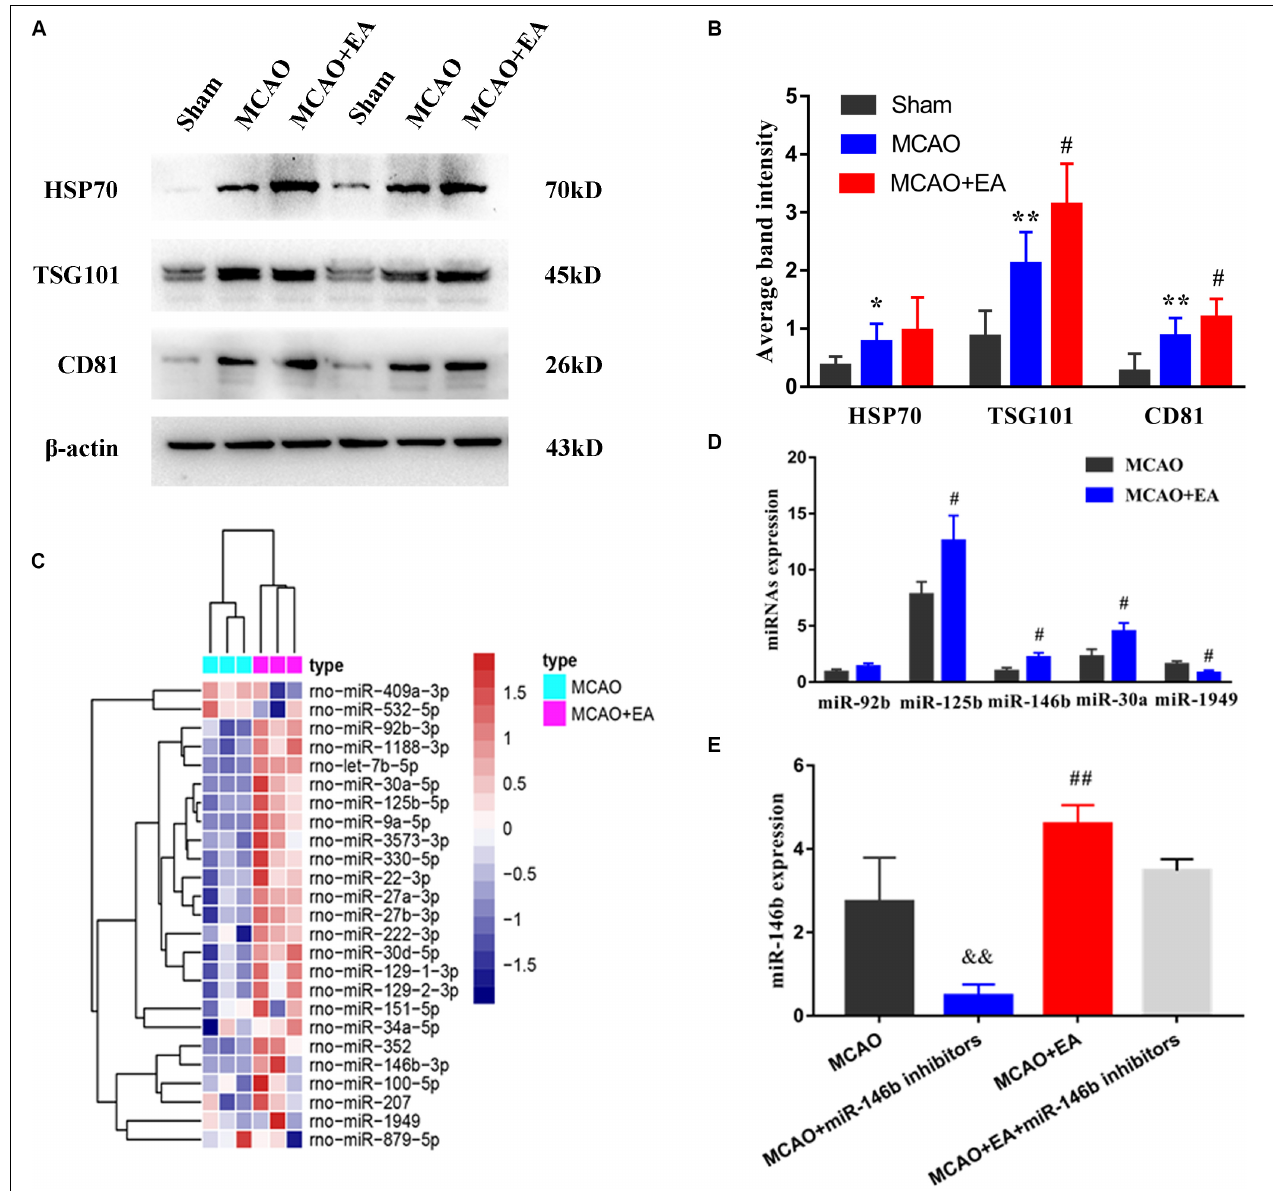
FIGURE 1 | Electro-acupuncture promotes the release of exosomal miR-146b in peri-ischemic striatum. (A) The expression of exosome-associated markers HSP70, TSG101, and CD81 were analyzed by Western blotting. (B) The expression of markers were quantified on the basis of average band intensity ( n = 4). (C) MiRNA microarray analysis of exosomes from peri-ischemic striatum and clustering of 25 significantly altered miRNAs with ≥ 1.5-fold difference in expression between MCAO and MCAO+EA groups. (D) Four miRNAs were significantly upregulated and 1 miRNA were downregulated in exosomes of the MCAO+EA group compared with the MCAO group were checked by RT-qPCR ( n = 3). (E) The expression of miR-146b in tissues of peri-ischemic striatum were analyzed form MCAO, MCAO+miR-146b inhibitors, MCAO+EA, MCAO+EA+miR-146b inhibitors groups ( n = 3). Data represent means ± SD of the results of representative experiment. * P < 0.05, MCAO vs. Sham; ** P < 0.01, MCAO vs. Sham; # P < 0.05 and ## P < 0.01, MCAO vs. MCAO+EA; && P < 0.01, MCAO vs. MCAO+miR-146b inhibitors; MCAO+EA vs. MCAO+EA+miR-146b